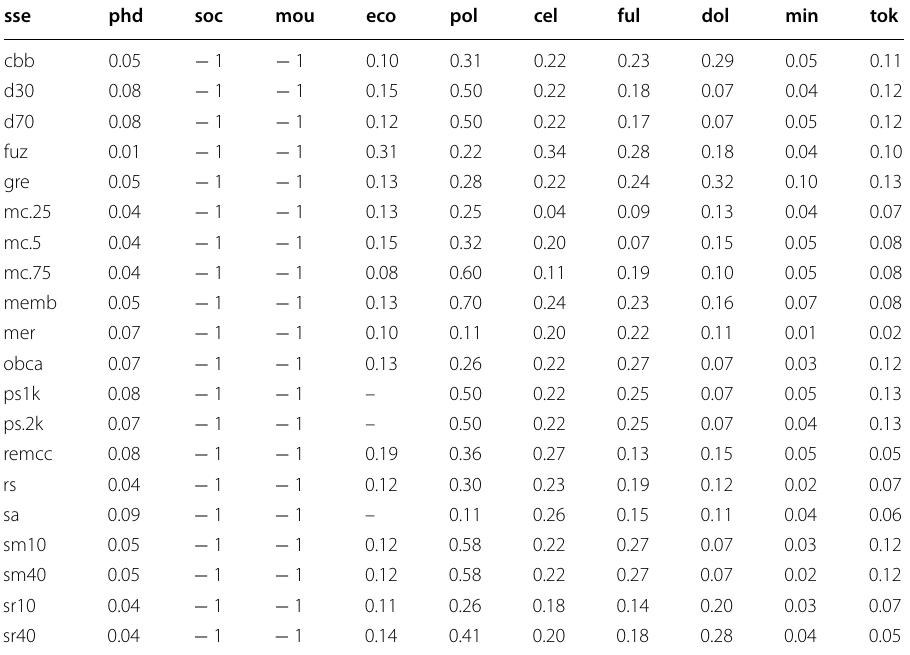
Here, 1.0 means that the network is not fractal or there are too few datapoints. The hyphens indicate the lack of data due − to the abort of the process